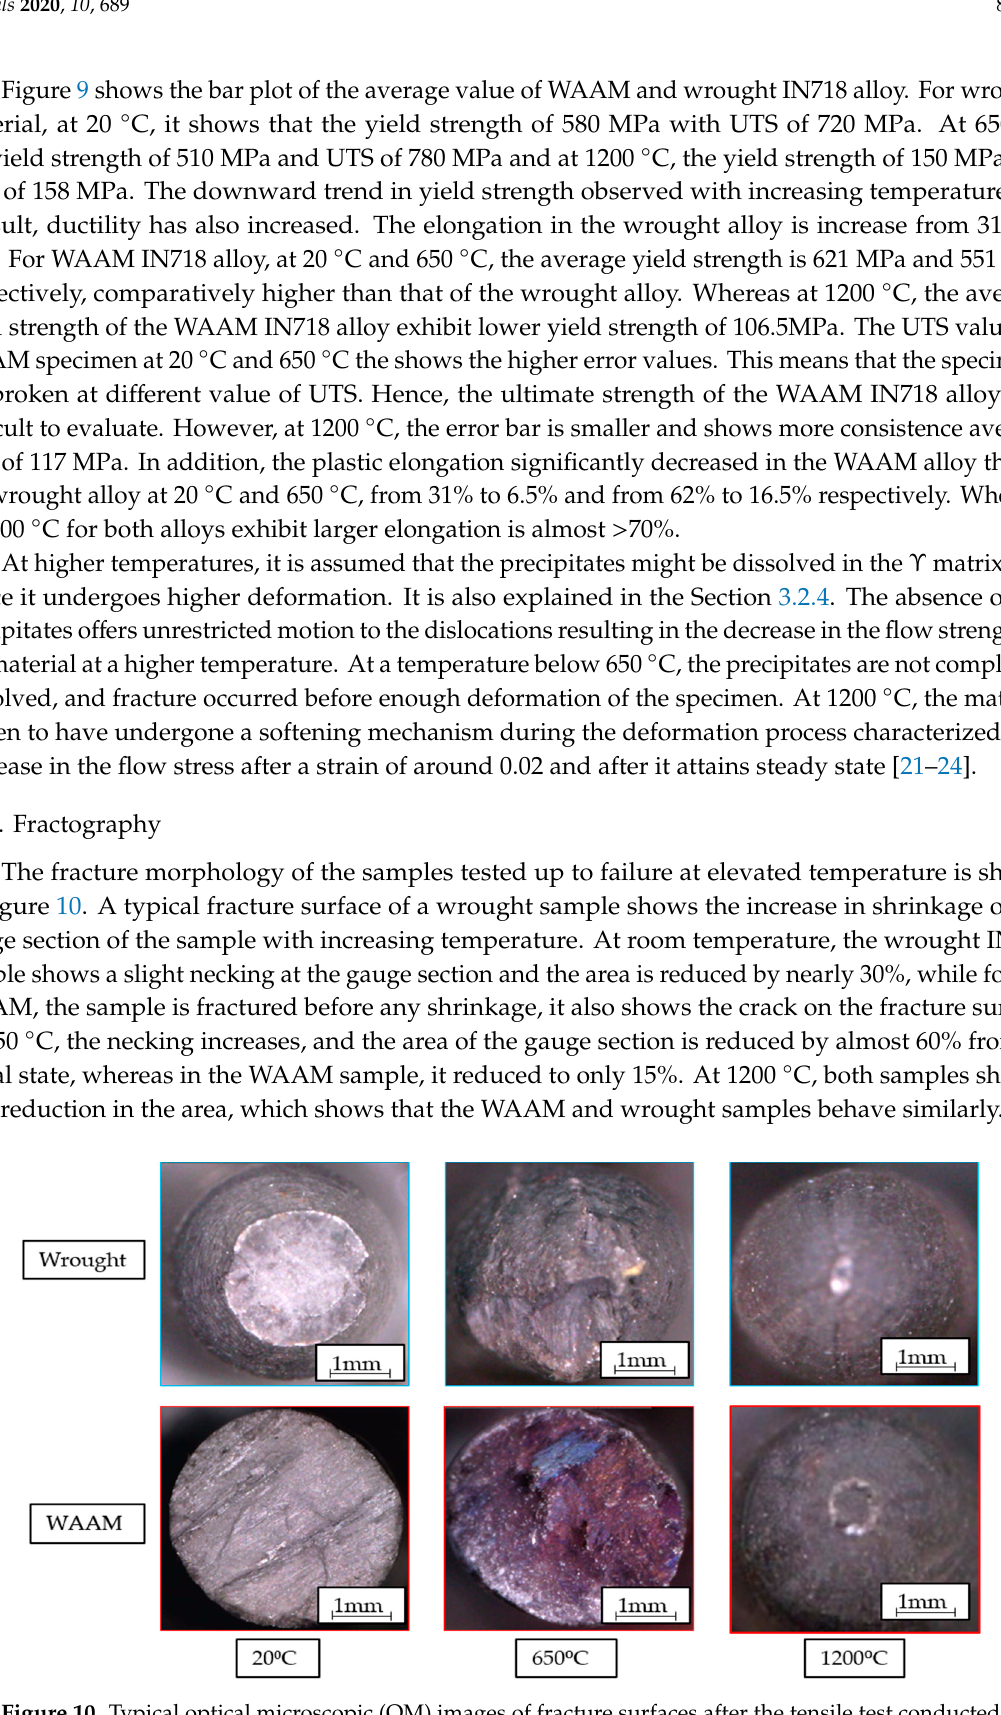
Figure 9. Mechanical properties of ( a ) WAAM ( b ) Wrought IN718 alloy at various temperatures.